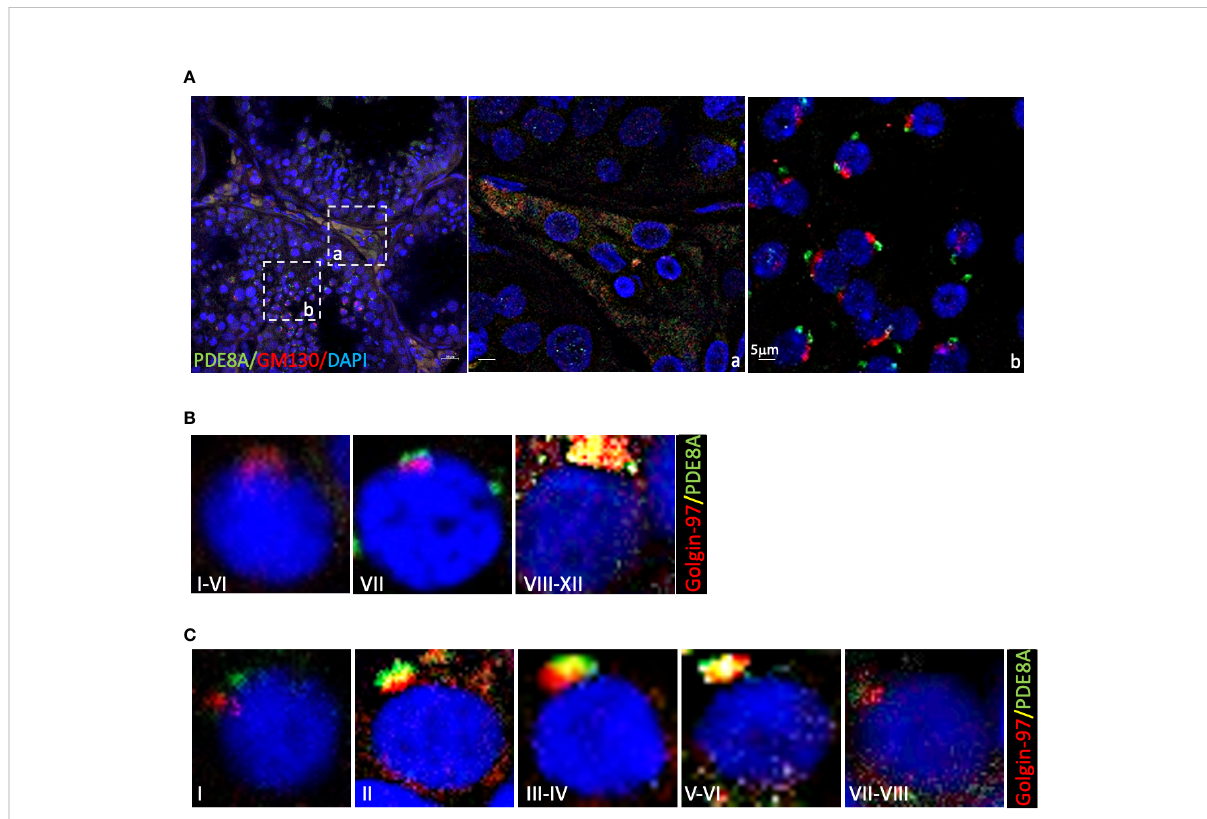
FIGURE 3 Co-localization of PDE8A and Golgi apparatus marker in different stages of human spermatogenesis (A) Co-localization analysis of PDE8A and GM130. Merged fl uorescent channel DAPI-nuclear staining (blue), PDE8A (green) and GM130 staining (red) are shown. Scale bars represent 20 m m, except for the inlet (A, B) . (B) PDE8A and Golgin97 co-localization analysis in human spermatocytes, to better show the differences between them the stages of the whole spermatogenic cycle are arbitrarily sub-divided into three parts. Merged fl uorescent channels DAPI- nuclear staining (blue), Golgin-97 (red) and PDE8A (green) are shown. (C) PDE8A and Golgin-97 co-localization analysis in human spermatids; to better show the differences between them the whole spermatogenic cycle are arbitrary sub-divided in fi ve. Merged fl uorescent channels DAPI- nuclear staining (blue), Golgin-97 staining (red) and PDE8A fl uorescence (green) are